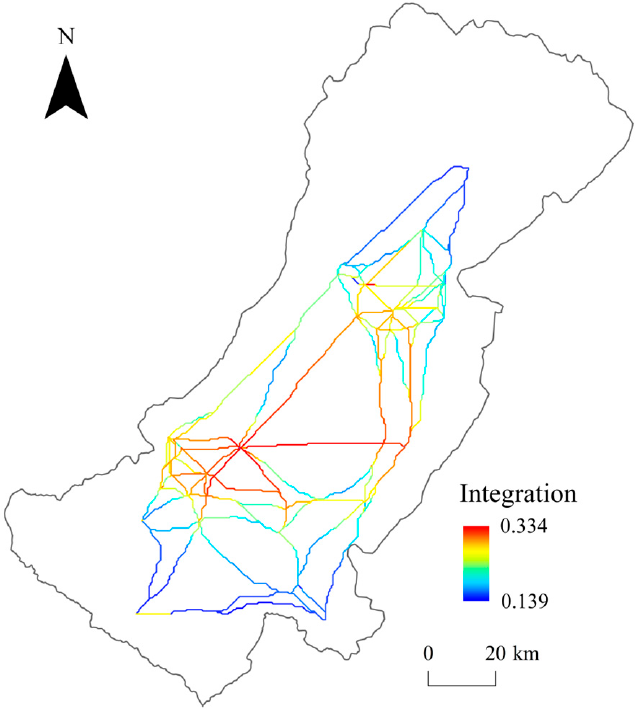
Figure 9. Global integration of EN in the study area.